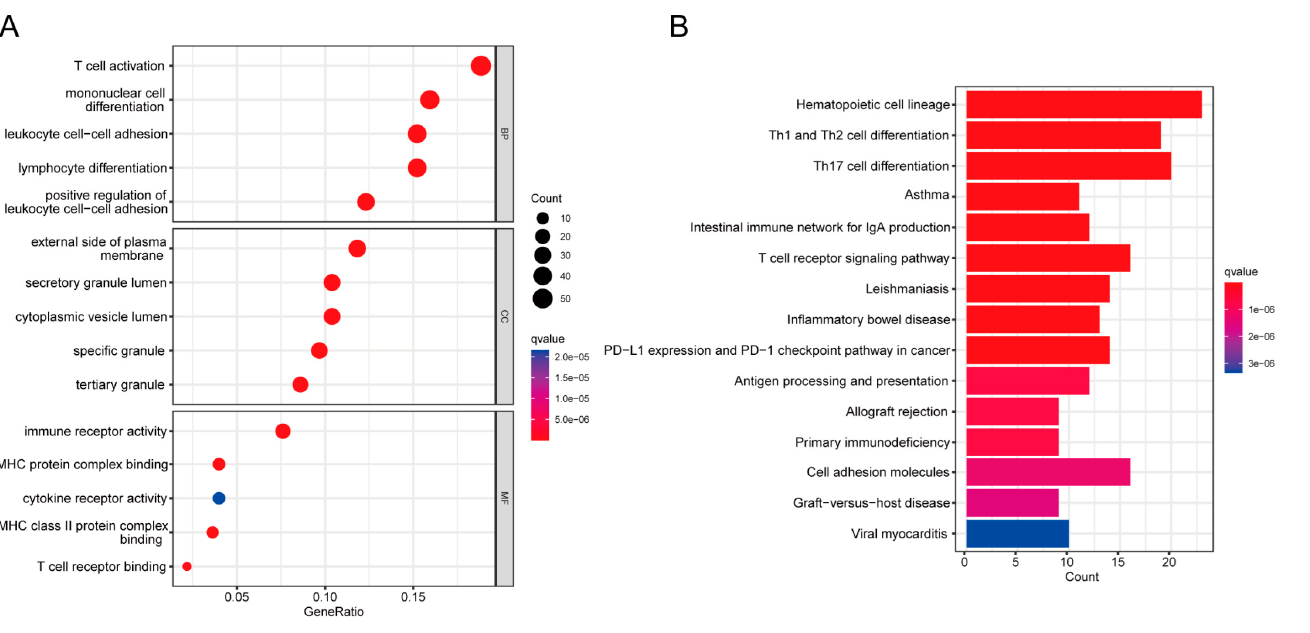
Figure 3. COVID-19 and sepsis genes with common differential expression were analyzed using GO and KEGG enrichment. ( A ) GO enrichment analysis histogram; (BP) biological process, (CC) cellular components, (MF) molecular function. ( B ) Bar plot of KEGG pathway analysis.